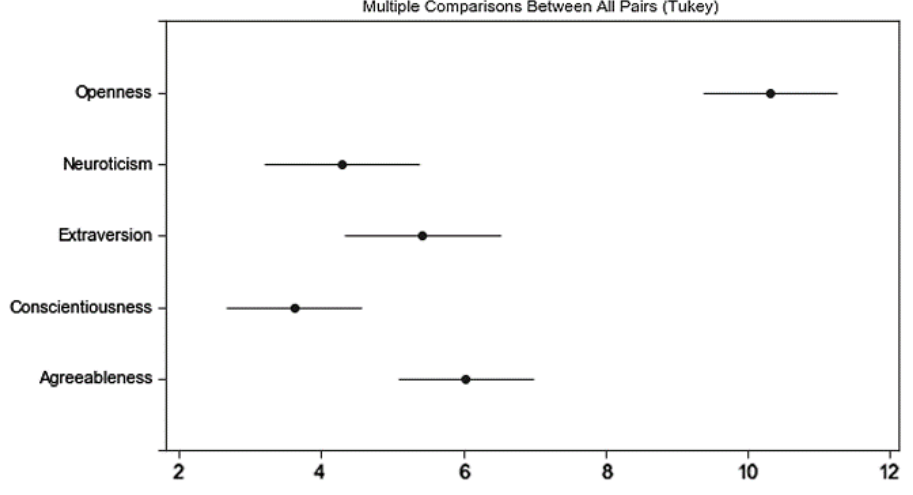
Figure 7. Difference between subdimensions of BFF in understanding consumer rating. Table 9. Di ff erence between subdimensions of psychographic in understanding user